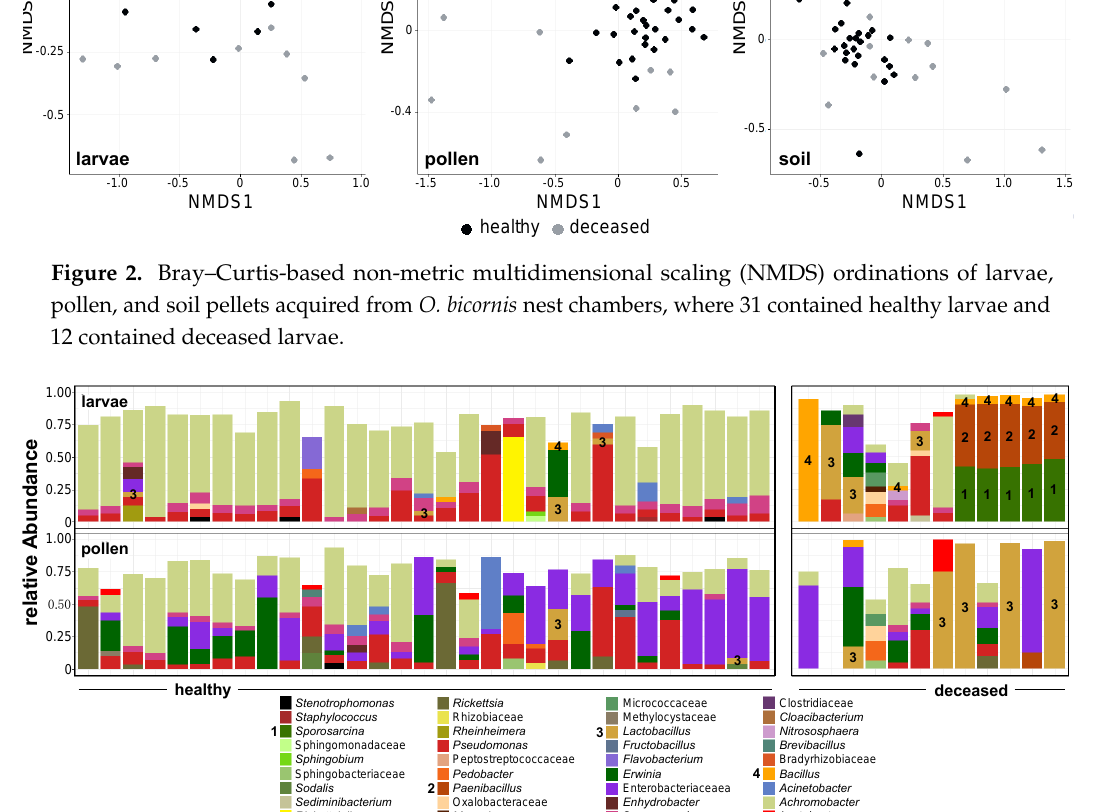
Figure 3. Bacterial composition in larvae ( top ) and pollen ( bottom ) samples acquired from 43 O. bicornis nest chambers belonging to different nests. Of these, 31 nest chambers contained healthy individuals ( starting left ) and 12 contained deceased individuals. Bacterial genera of special interest and further discussed in the text are referred to with numbers. Taxa are agglomerated up to genus level (family level if not further classifiable). Taxa contributing less than 5% to the dataset are not represented in the legend and